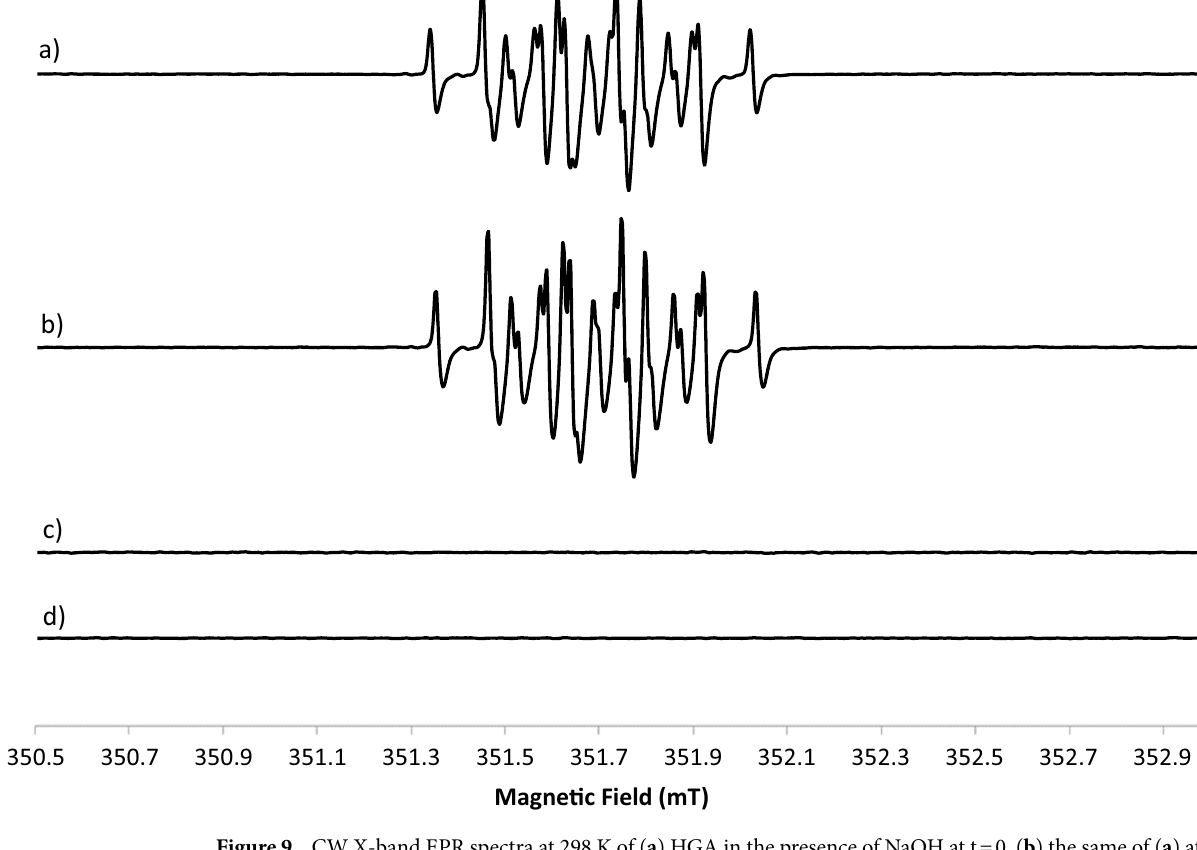
Figure 9. CW X-band EPR spectra at 298 K of ( a ) HGA in the presence of NaOH at t = 0, ( b ) the same of ( a ) at t = 15 min, ( c ) HGA in the presence of NaOH and treated with HCl at t = 0, ( d ) HGA in buffer at pH = 8.